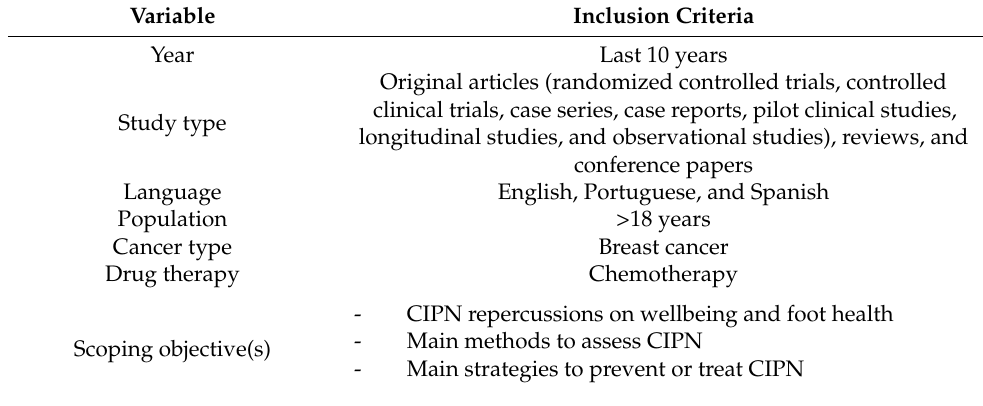
Table 1. Inclusion criteria. Variable Inclusion Criteria Original articles (randomized controlled trials, controlled clinical trials, case series, case reports, pilot clinical studies, longitudinal studies, and observational studies), reviews,